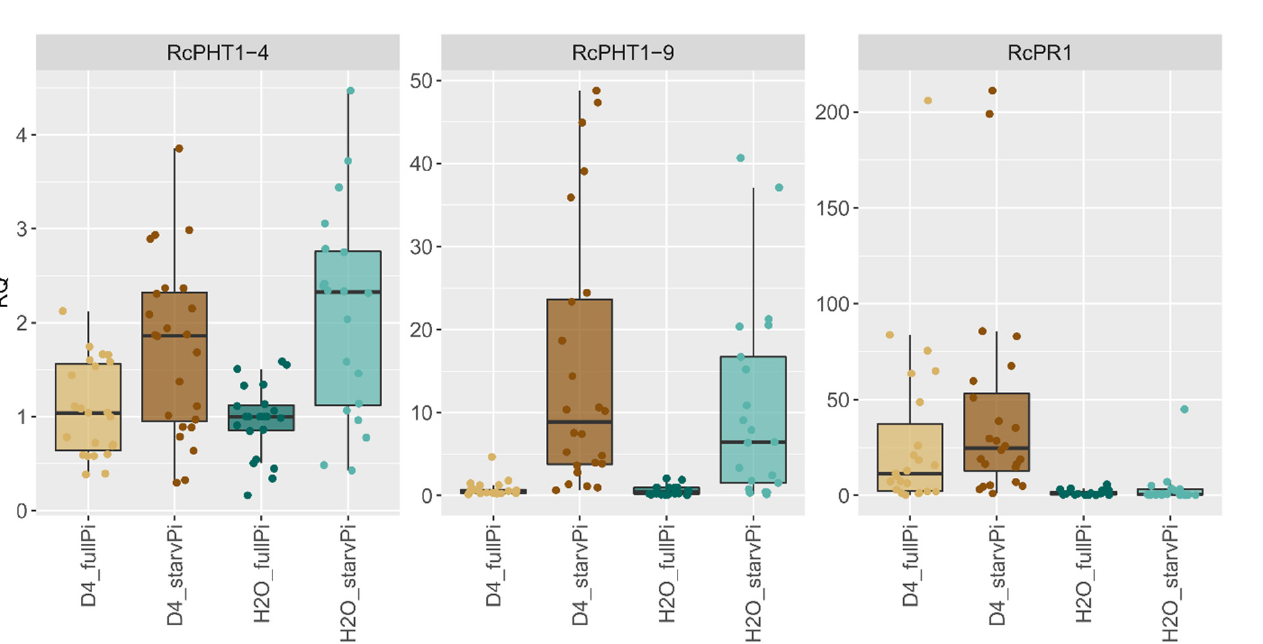
Figure 5. RT-qPCR analysis of a combined stress experiment in leaves of six 97/7 rose genotypes at 3 dpi. Two Pi treatments (“fullPi” and “starvPi”) and additional inoculation with D. rosae (“D4”). Expression data of all six genotypes have been combined under each treatment. Expression changes of each genotype relative to “H 2 O_fullPi”. Data are represented as boxplots of RQ values (relative quantification = 2 −ΔΔ Ct ) and single points, n = 24.